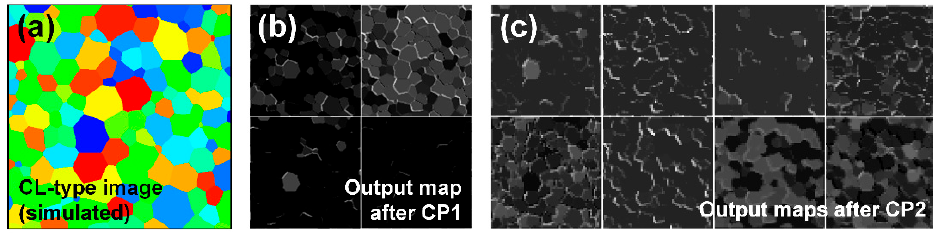
Figure 11. Mid-layer images for a simulated CL-type image. ( a ) Original image (512 × 512 pixels) and mid-layer images after ( b ) CP1 (128 × 128 pixels each) and ( c ) CP2 (64 × 64 pixels each) layers.